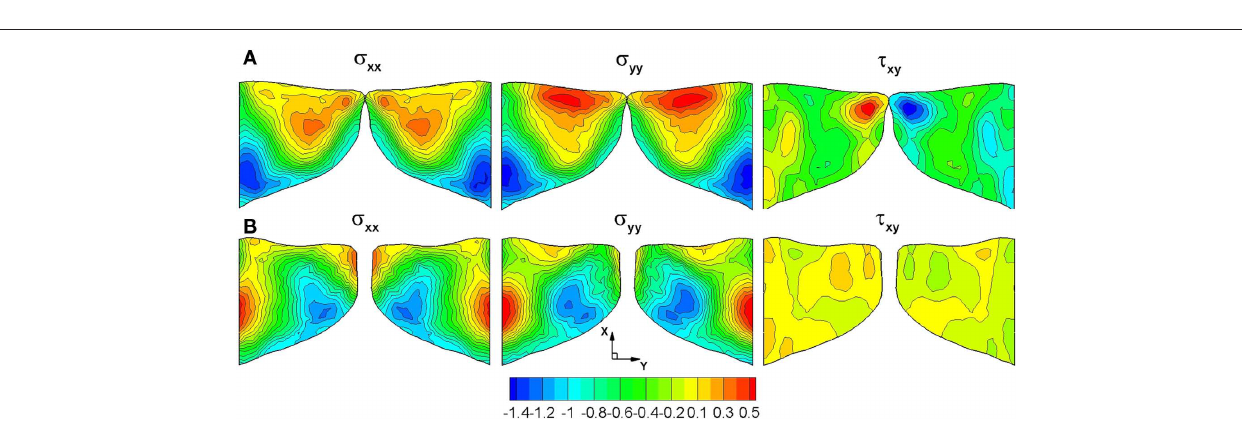
Figure 10 | Stress contours (kPa) on the center plane ( z = 0.75 cm) of the vocal folds during the opening and closing phase of the vibration cycle (A) Beginning of the opening phase (B) Maximal